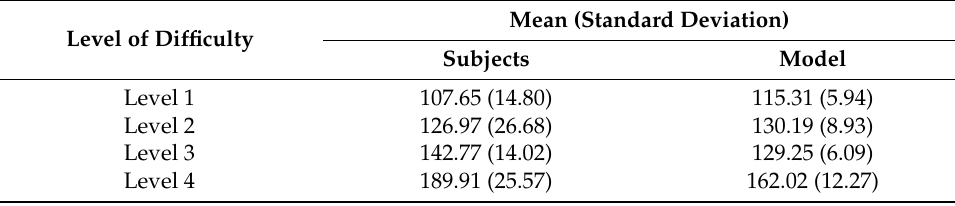
Figure 9. Total performance time of the illustrated dual task, including the memory game and the subitizing task, for the subjects and model. Table 6. Total performance time (s) of the illustrated dual task for subjects and model.